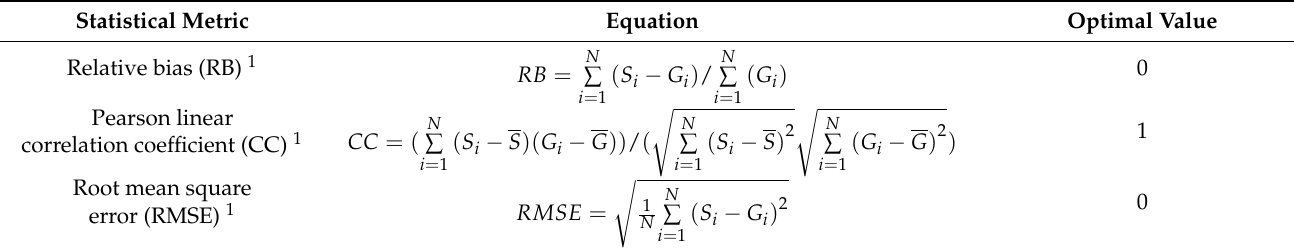
Table 1. Statistical metrics used in this study.